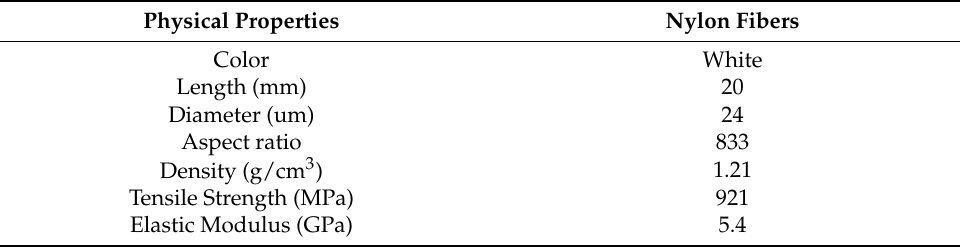
Table 4. Physical Properties of Nylon